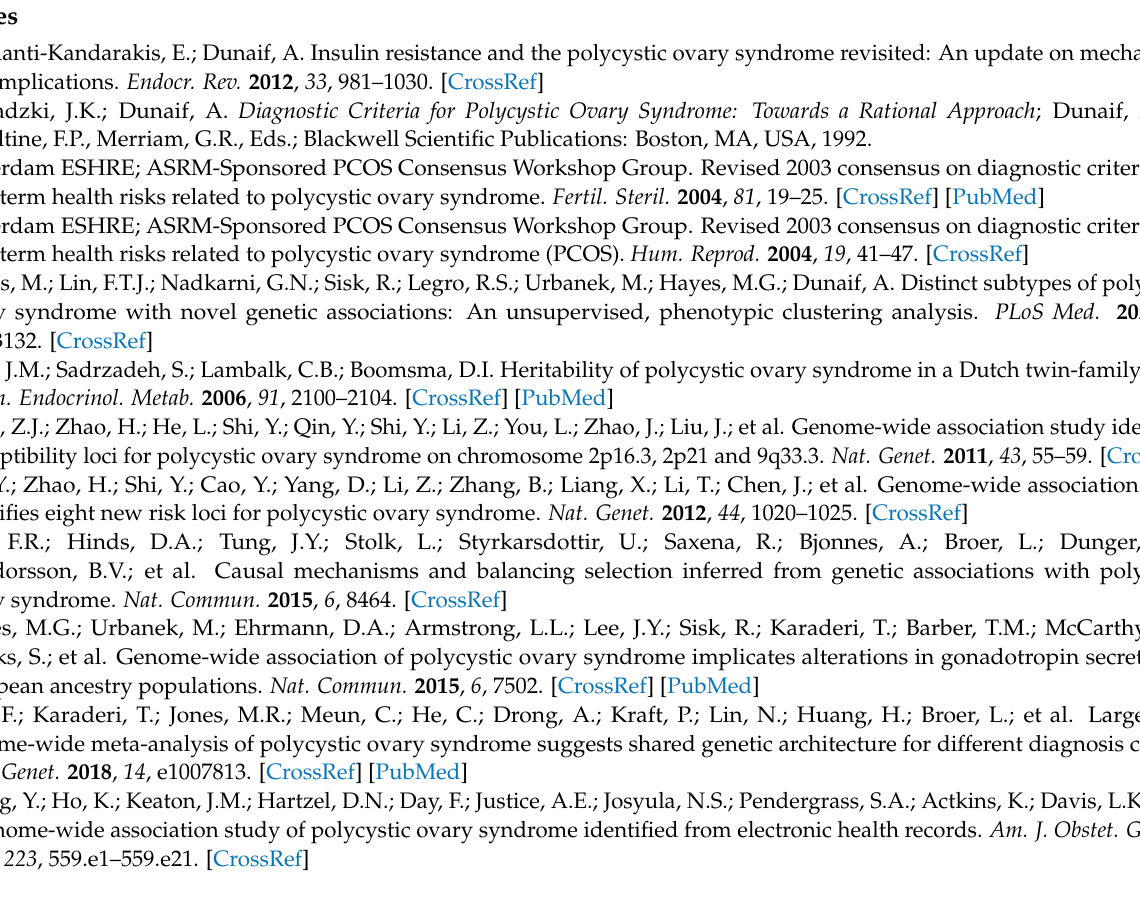
Supplementary Table S2: List of GWAS datasets of PCOS-related traits and disease outcomes, Supplementary Table S3: Z score for 26 PCOS SNV–quantitative trait associations, Supplementary Table S4: The 53 instrumental variables for composed insulin-resistant